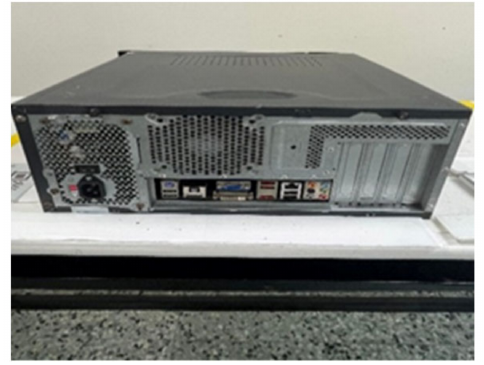
Figure 2. A desktop